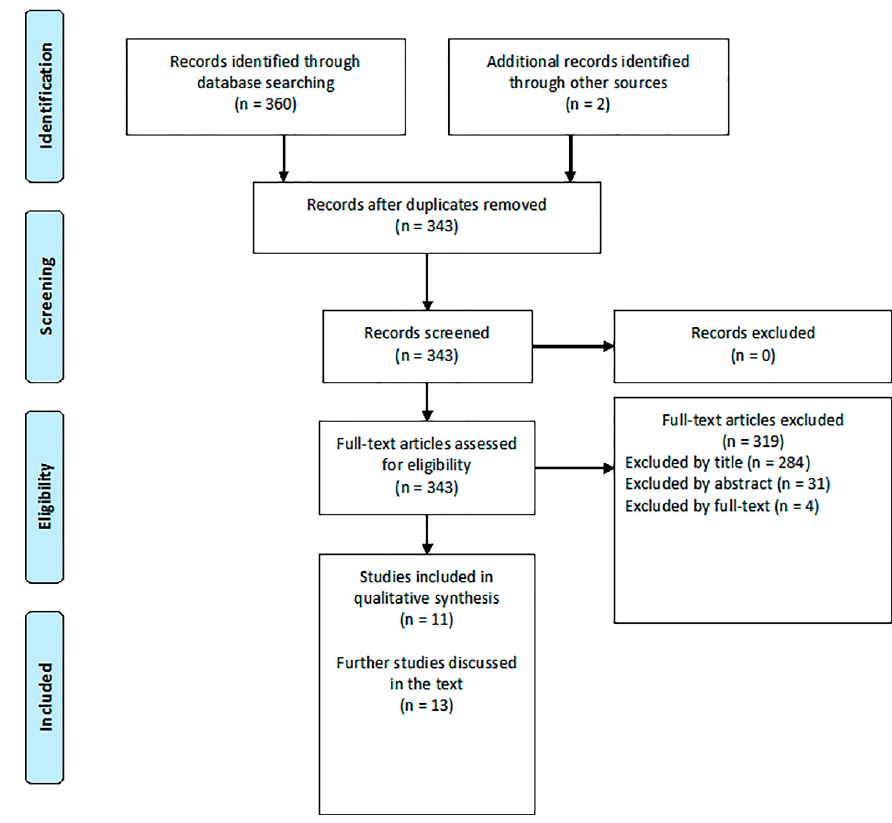
Figure 1. Flowchart for literature review.